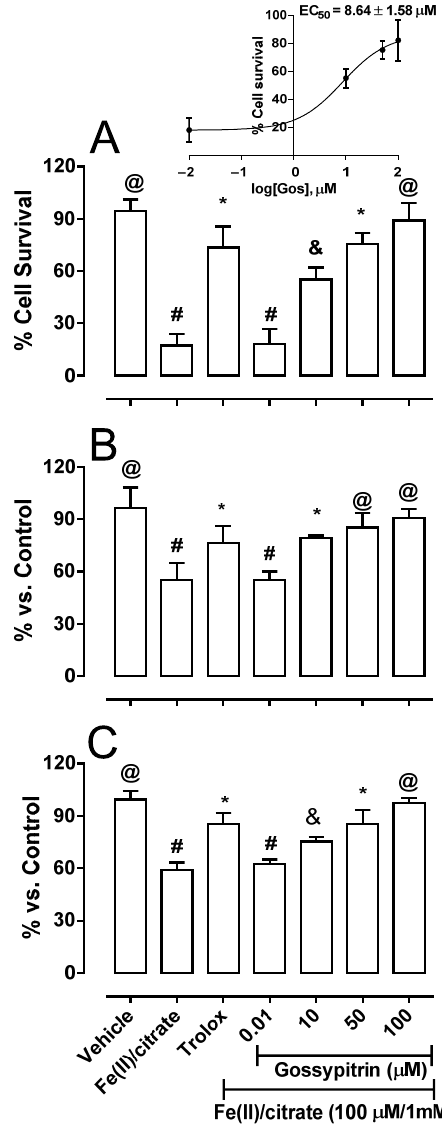
Figure 2. Gos protection against iron-induced neuronal cell damage. Effects of Gos on HT-22 mouse hippocampal neuron survival ( A ), cellular mitochondrial membrane potential ( B ), and cellular ATP levels ( C ). Gos (0–100 µ M) or Trolox (500 µ M) were co-incubated for 24 h (viability) or 2h (mitochondrial membrane potential and ATP levels) with 100 µ M FeCl 2 /1 mM citrate. The assay conditions are described in Section 4. Damaged control cells (without Gos) contained DMSO (0.001%) plus the iron-citrate mixture. The results are expressed as the percentage of cell death in relation to the undamaged control (containing DMSO 0.001% as the vehicle). Values are the means ± S.D. of three different experiments. Different symbols indicate statistical differences at p < 0.05 when comparing all pairs of experimental groups according to the ANOVA and post hoc Newman-Keuls tests. (If the symbols are different among groups indicate statistical differences, when they are equal, there is not.) HT-22 exposure to iron for 2 h (prior to cell death execution) induced the dissipation of the mitochondrial membrane potential, as estimated by the retention of rhodamine 123 association between the toxic iron-mediated effects on the mitochondria and cell viability.